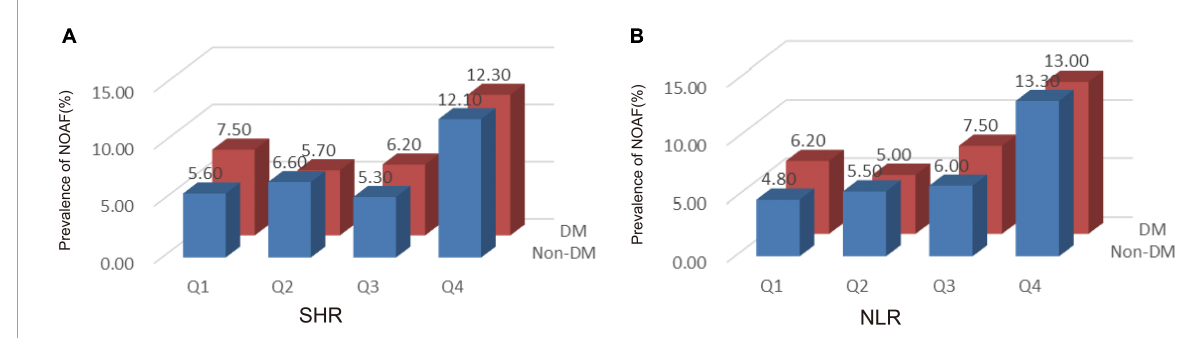
FIGURE2 The incidence of new-onset atrial fibrillation (NOAF) in patients with acute myocardial infarction (AMI) according to tertiles of stress hyperglycemia ratio (SHR) (A) and neutrophil to lymphocyte ratio (NLR) (B) . SHR, stress hyperglycemia ratio; DM, diabetes mellitus; NOAF, new-onset atrial fibrillation.